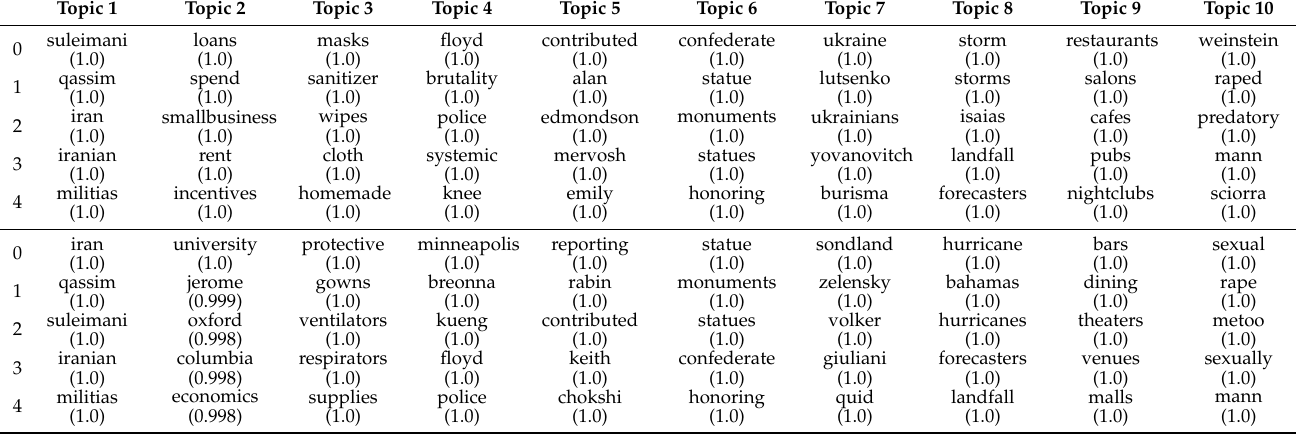
Table A20. For the most significant two words per topic, the four nearest neighbors based on cosine similarity are